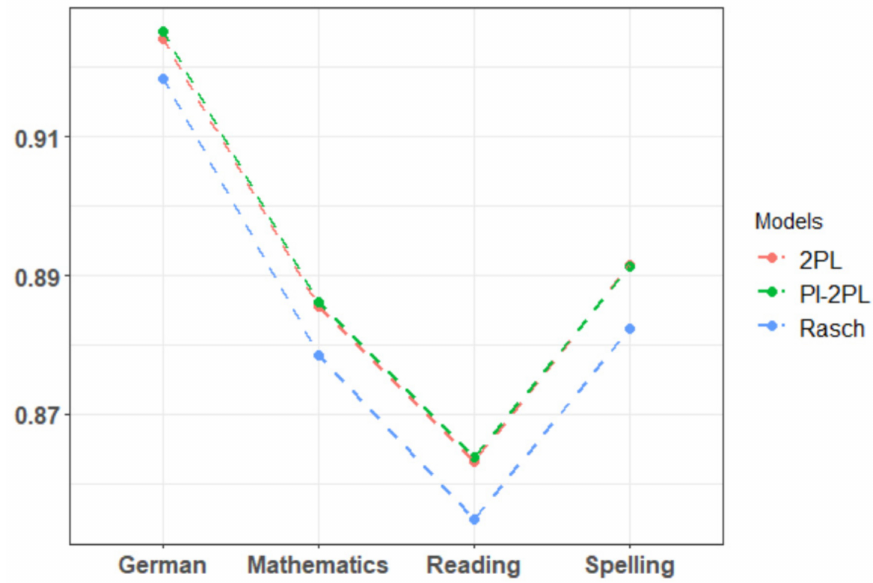
Figure 4. Reliability of test scores with multigroup concurrent calibration on gender misfit.